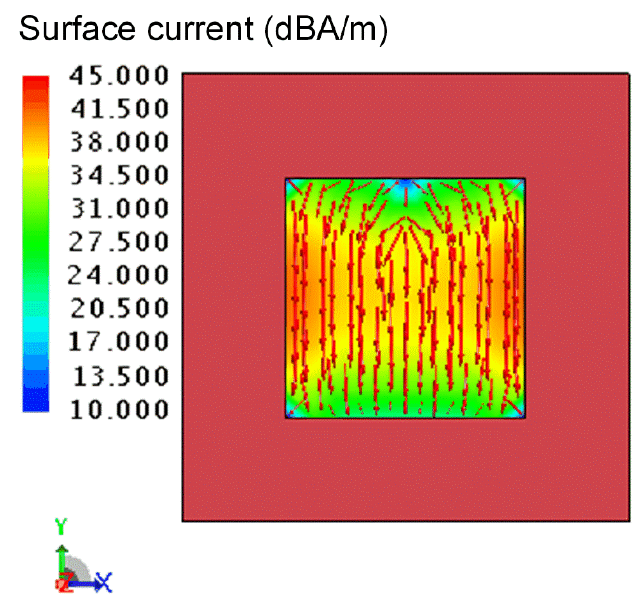
Figure 5. Current distribution on the patch surface.